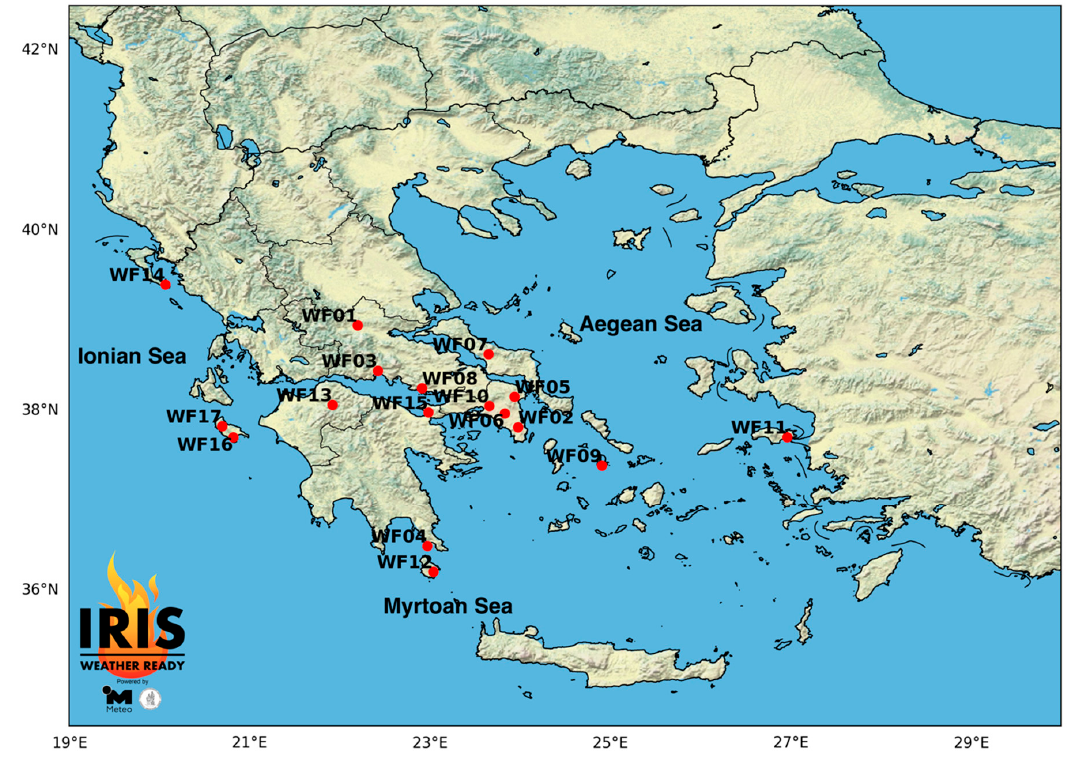
Figure 1. Locations of the 17 wildfires for which IRIS was activated during the 2019 fire season in